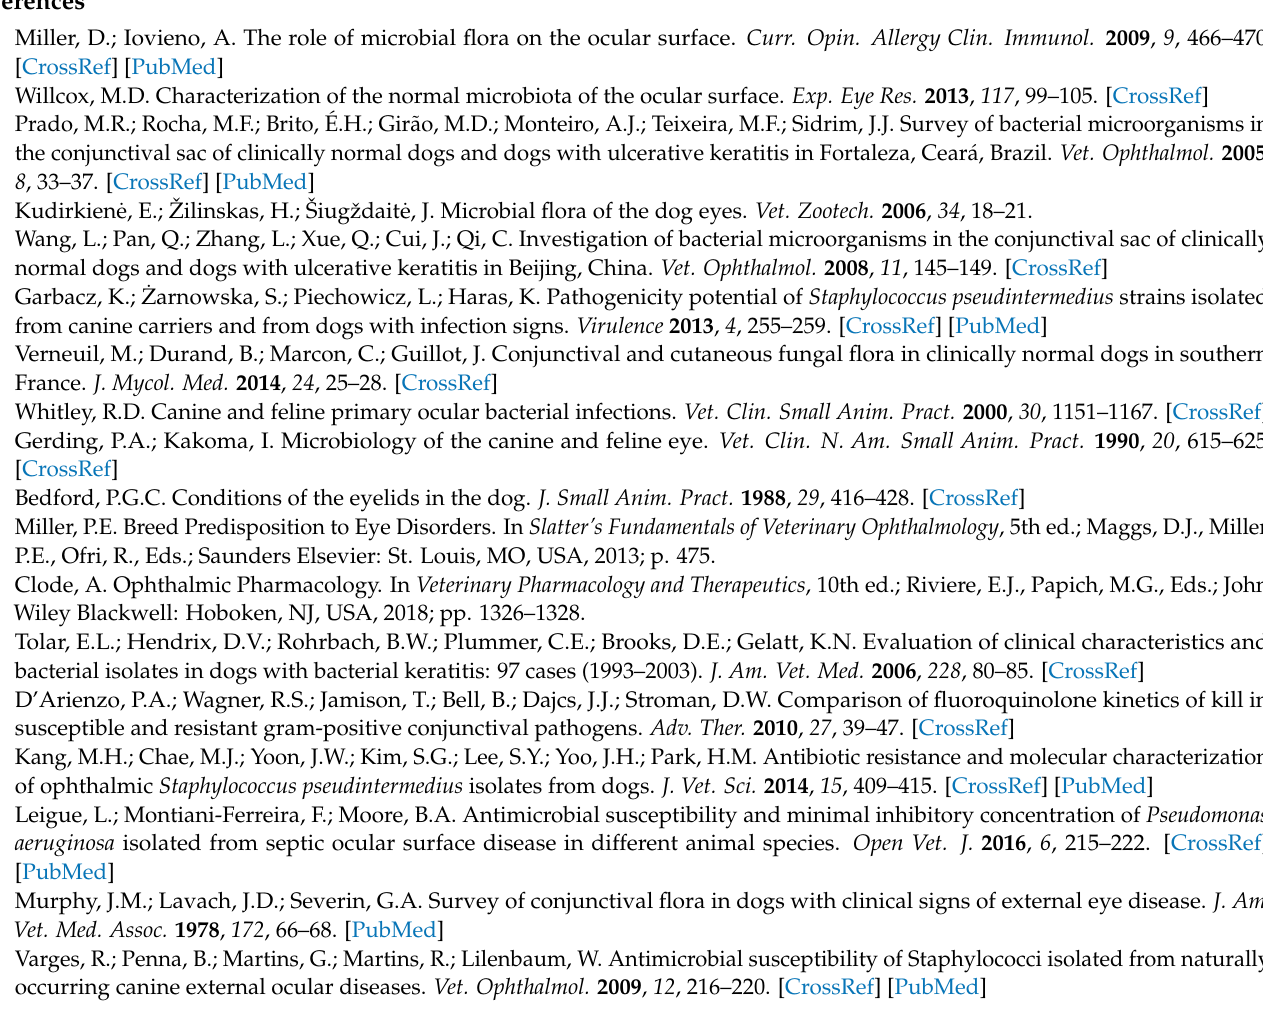
Supplementary Materials: Table S1: Supplementary data of bacterial genera identification criteria and breakpoints establishing